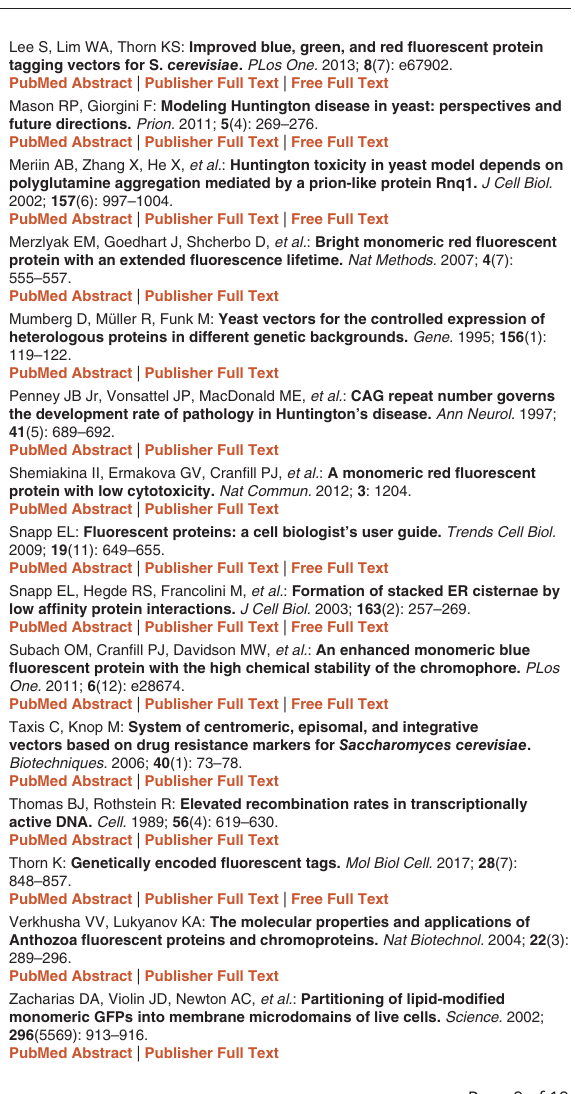
F1000Research: Dataset 1. Raw data behind Figure 1, Figure 2, Figure 3 and Figure 4, https://doi.org/10.5256/f1000research. 15829.d225385 (Albakri et al ., 2018) Both p415 GPD-yFusionRed and p415 GPD-ymScarlet are available from addgene (#111916/11917). All plasmids are available upon request from the corresponding